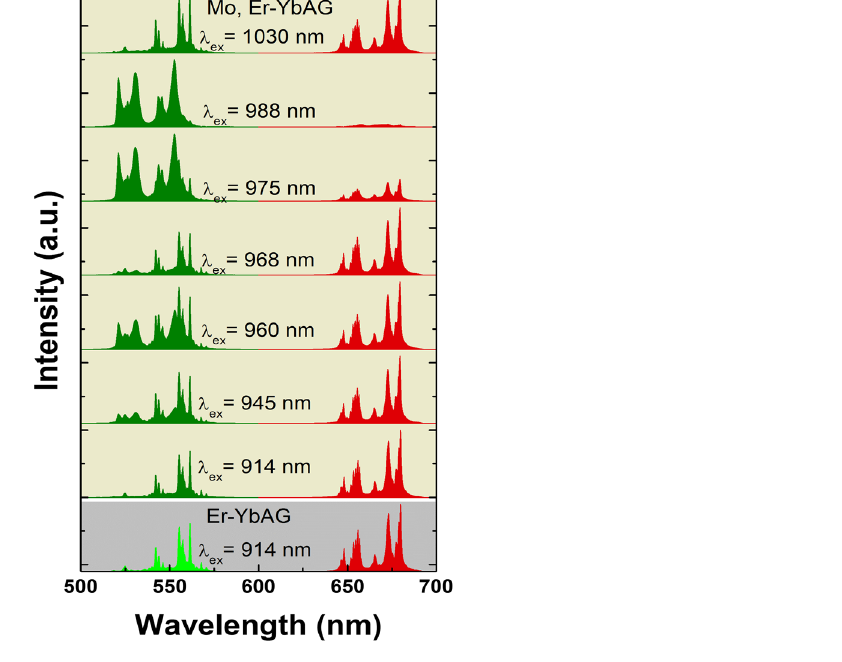
Figure 3. Upconversion emission spectra of Er-YbAG and Mo, Er-YbAG using variable pulse excitation (at 20 mJ/cm 2 ) across Yb absorption (914–1030 nm).